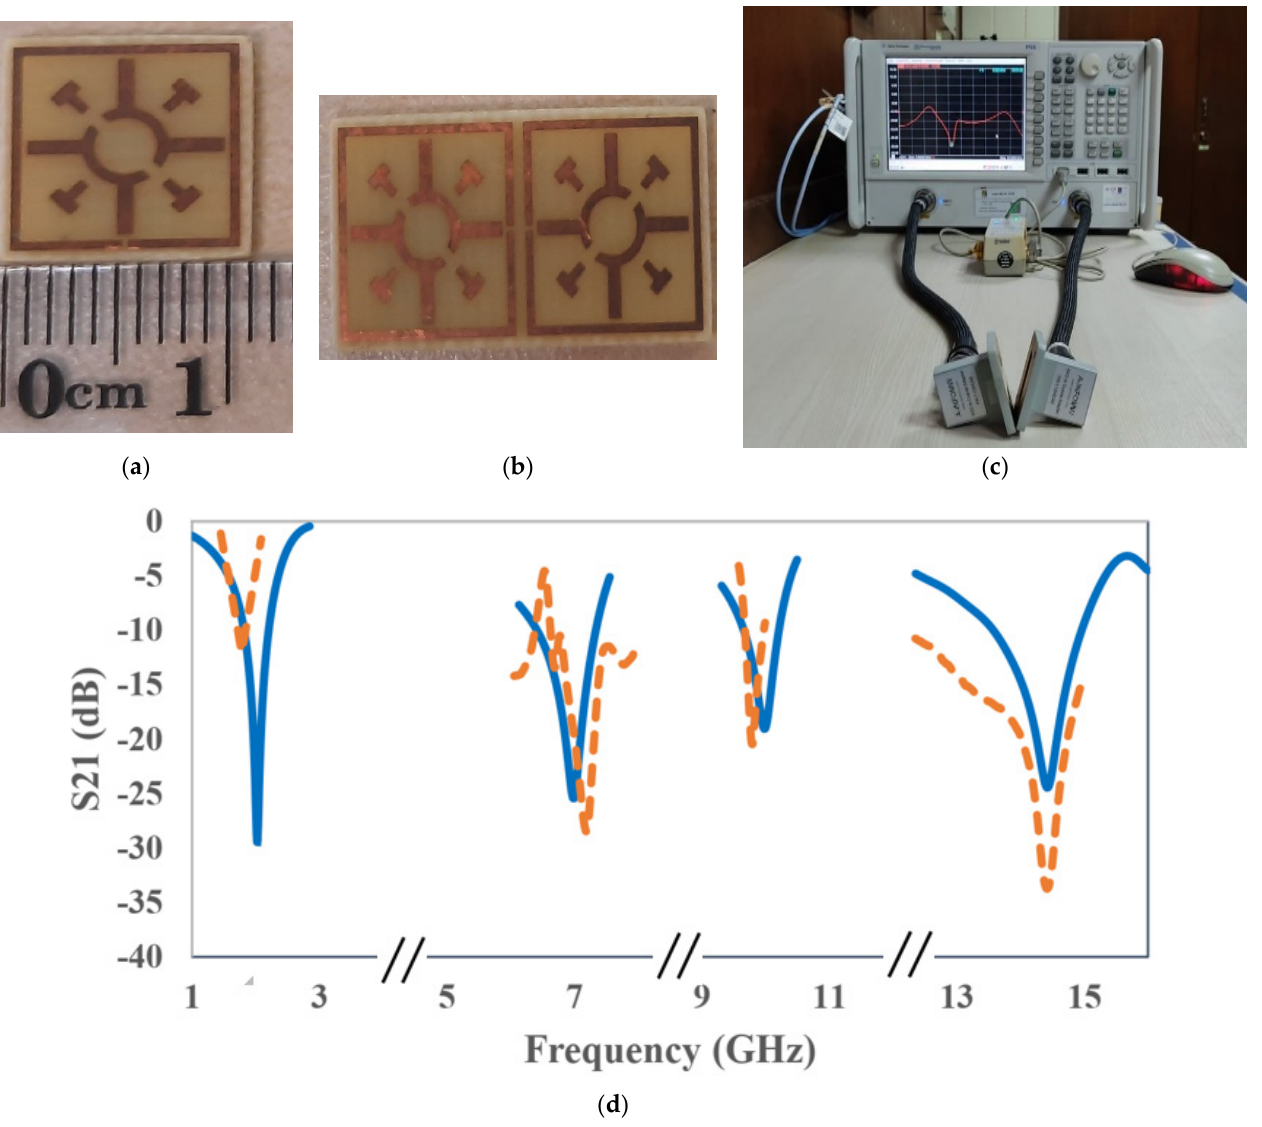
Figure 9. Graphical view of the ( a ) fabricated prototype of the unit cell, ( b ) 1 × 2 array, ( c ) measure- ment setup, and ( d ) S 21 using simulated and measured results.